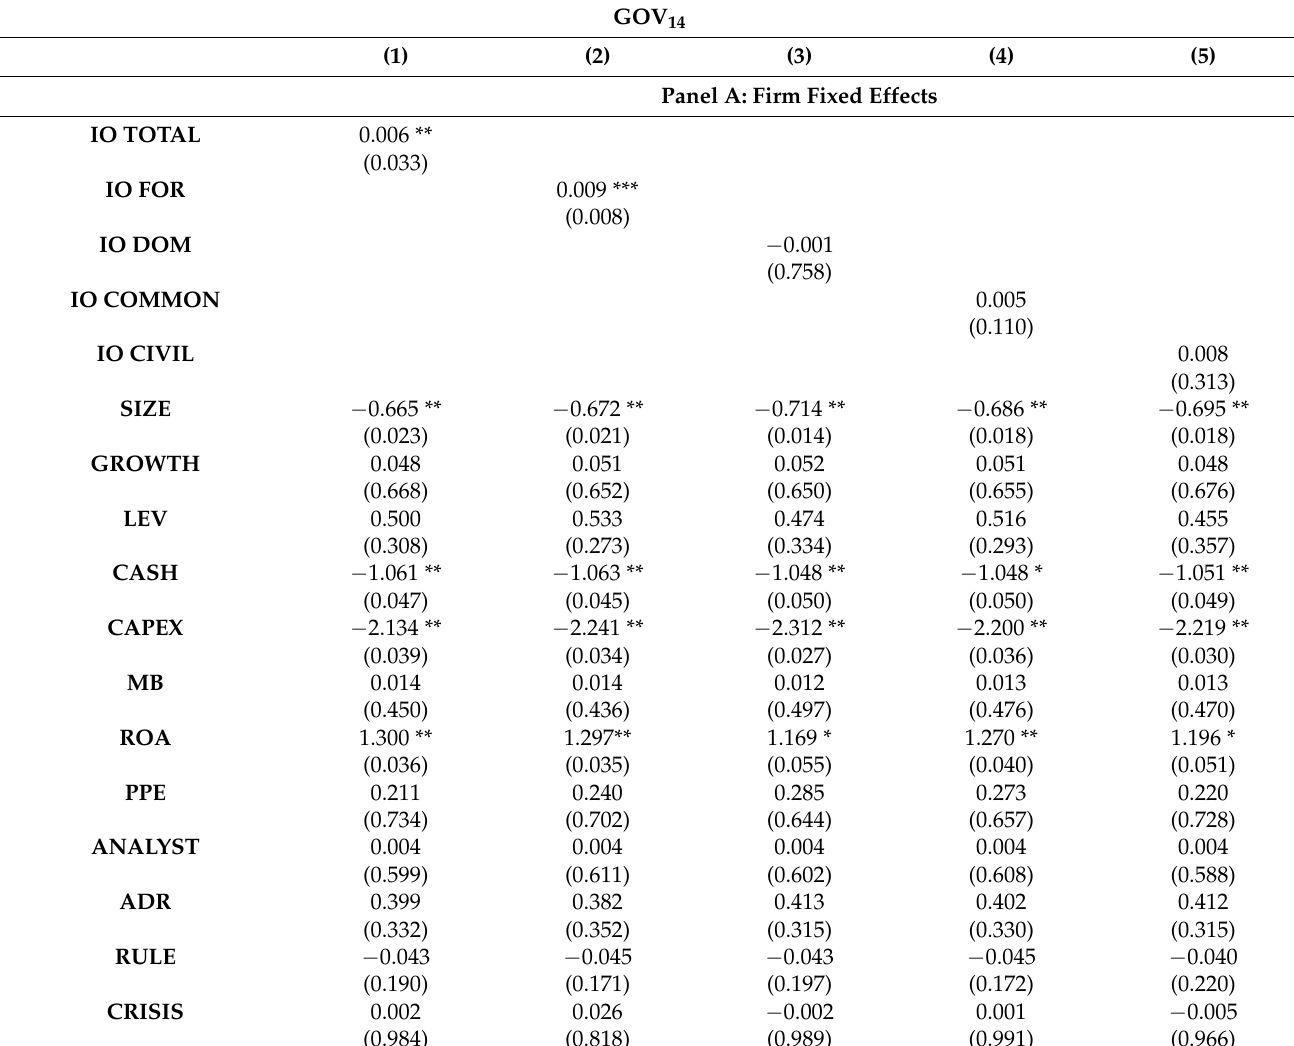
Table 2. Institutional ownership and corporate governance.